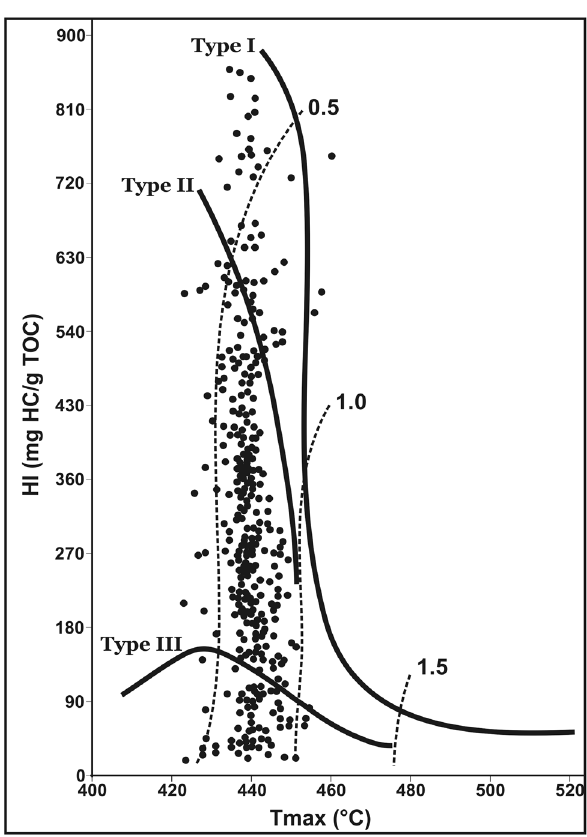
Fig. 8 HI/ T max diagram showing the representative points of Bir M’Cherga Aptian–Albian source rocks (Corel Draw figure exported into jpeg